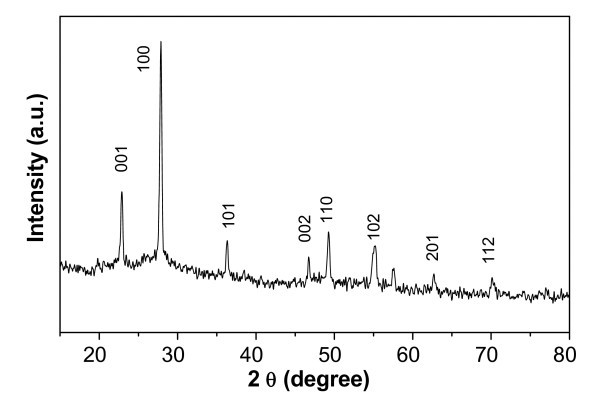
XRD pattern of Nb2O5 nanorod precursors. All the peaks can be indexed to the orthorhombic Nb2O5 (JCPDS no. 30-0873).